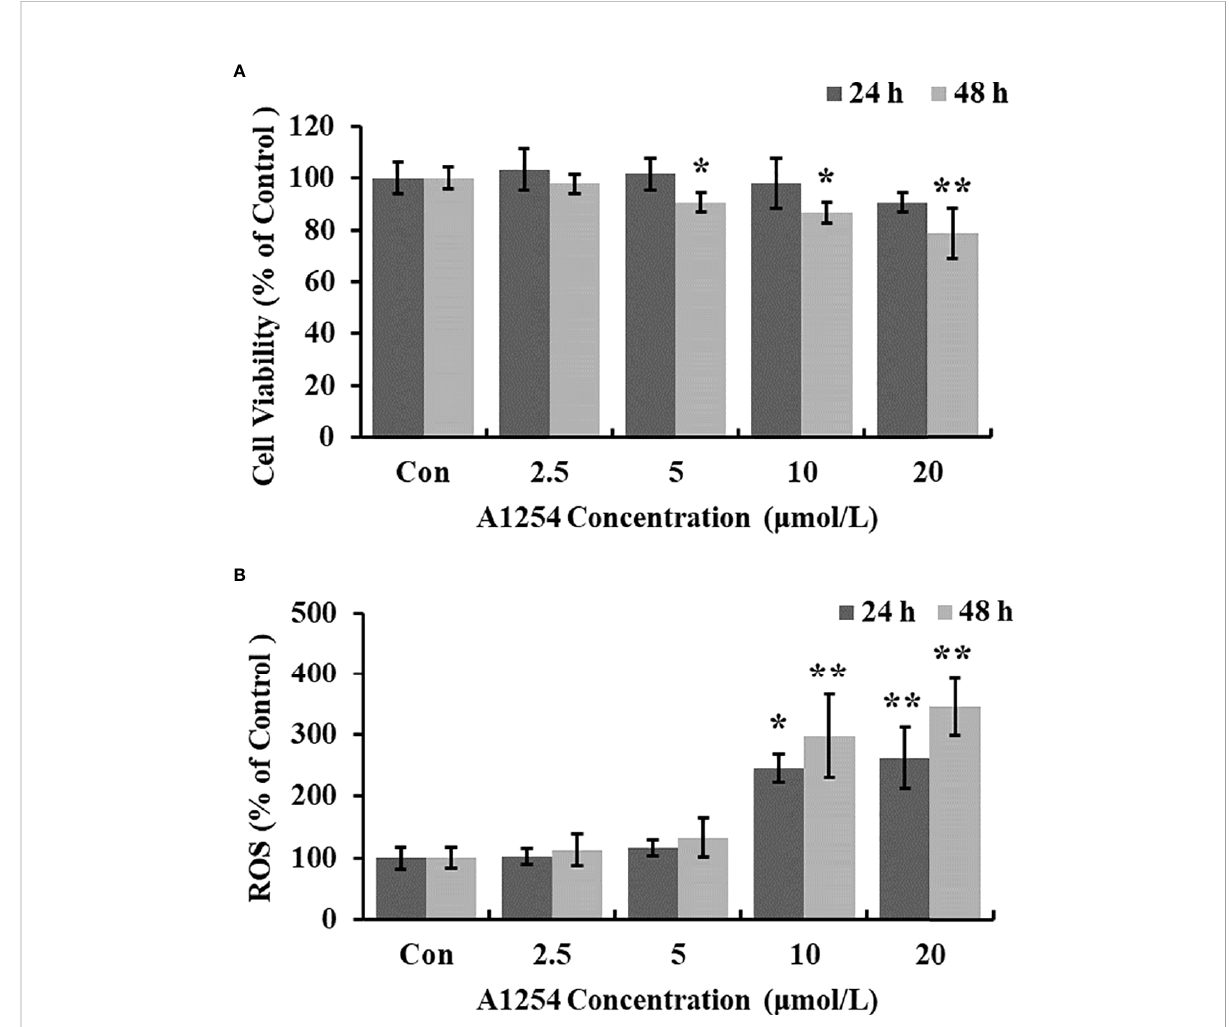
FIGURE 1 The cell viability and ROS level after A1254 exposure. MC3T3-E1 were incubated with various doses (0, 2.5, 5, 10, 20 m mol/L) of A1254 for 24h or 48h. (A) Cell survival was assayed by MTT assay. (B) ROS levels were determined with fl uorescence microscopy using DCFH-DA probe. The fl uorescent intensity was measured at 485 nm excitation and 530 nm emission, and analyzed using the Ipwin32 software. Each experiment was repeated three times with 8 replicates for each concentration group. * p <0.05, ** p <0.01 compared to